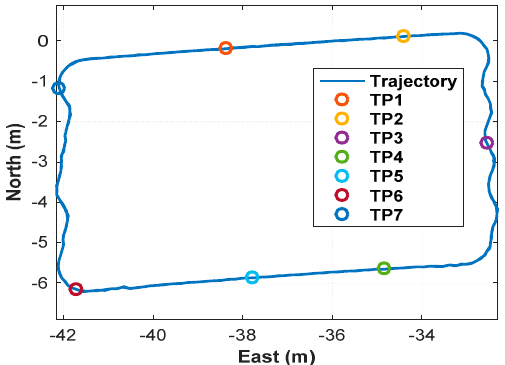
Figure 14. The estimated trajectory of the toy train.